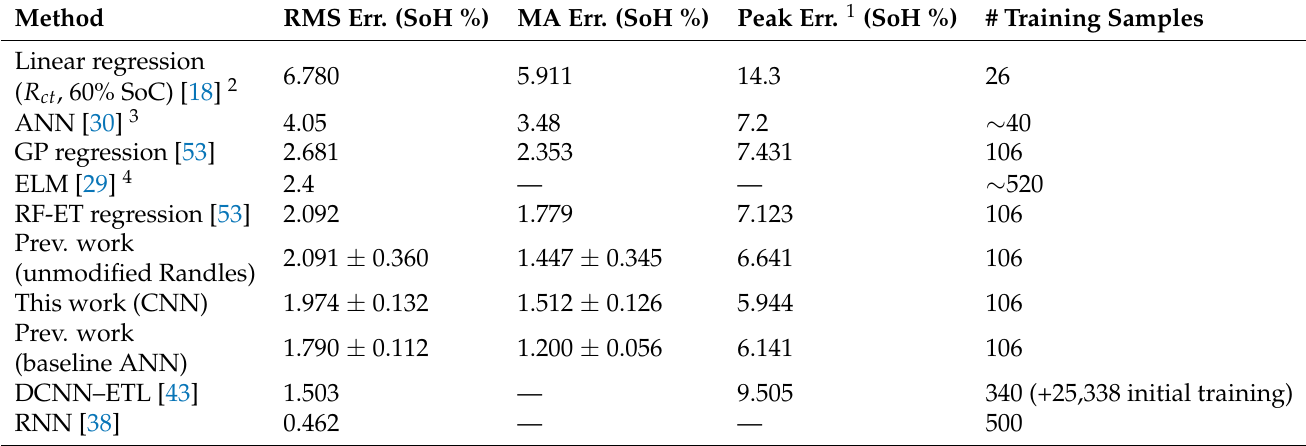
Table 4. Overview of RMS, mean absolute, and peak prediction errors between this work, machine learning approaches covered by existing studies, and commonly used learning-based methods—Gaussian process (GP) and random forest extra-trees (RF-ET)